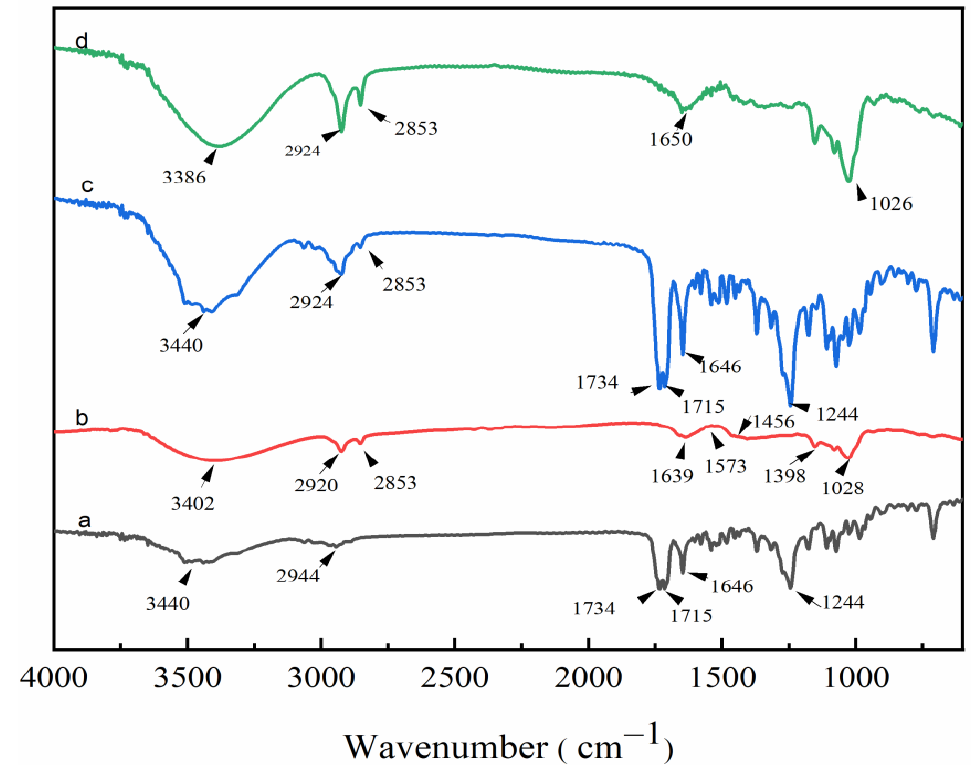
Figure 3. FTIR spectra of PTX ( a ), 6- β -CD-N-ODMA ( b ), mixture (PTX and 6- β -CD-N-ODMA) ( c ), and PTX/6- β -CD-N-ODMA ( d ).